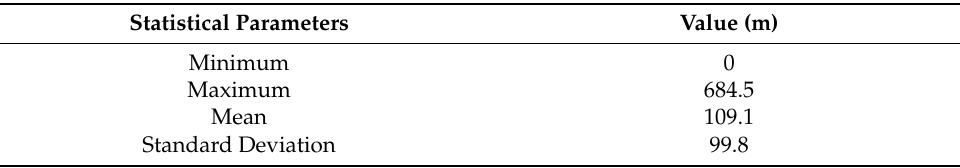
Table 3. Statistical parameters of the land–water boundary.